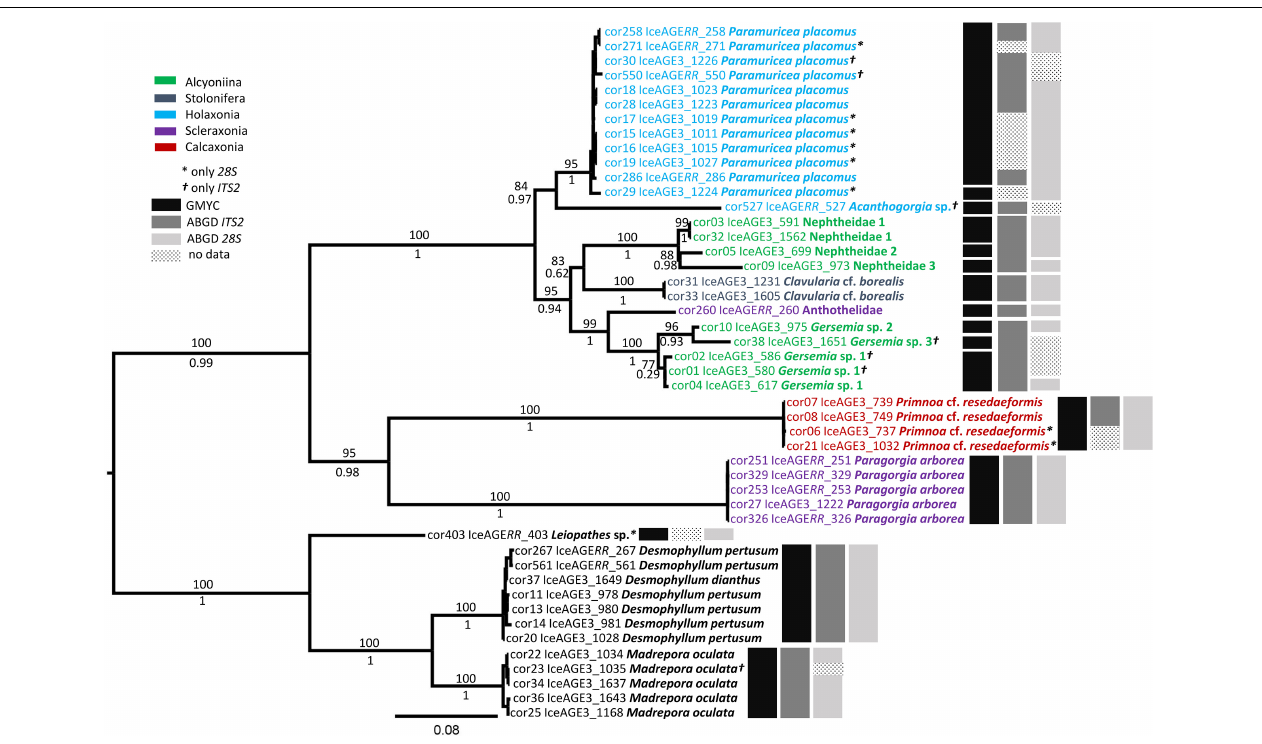
FIGURE 3 | The phylogenetic tree of the Octocorallia and the Scleractinia based on the Maximum Likelihood (ML) analysis of concatenated sequence data from 47 specimens for the nuclear gene ITS2 and 28S rDNA. Bootstrap percentages of the ML analysis are given above the branches. The black and gray bars on the right show the results of the GMYC and ABGD species discrimination methods, respectively. The GMYC model was achieved with the concatenated sequence data. ABGD method was performed with single alignment data for each